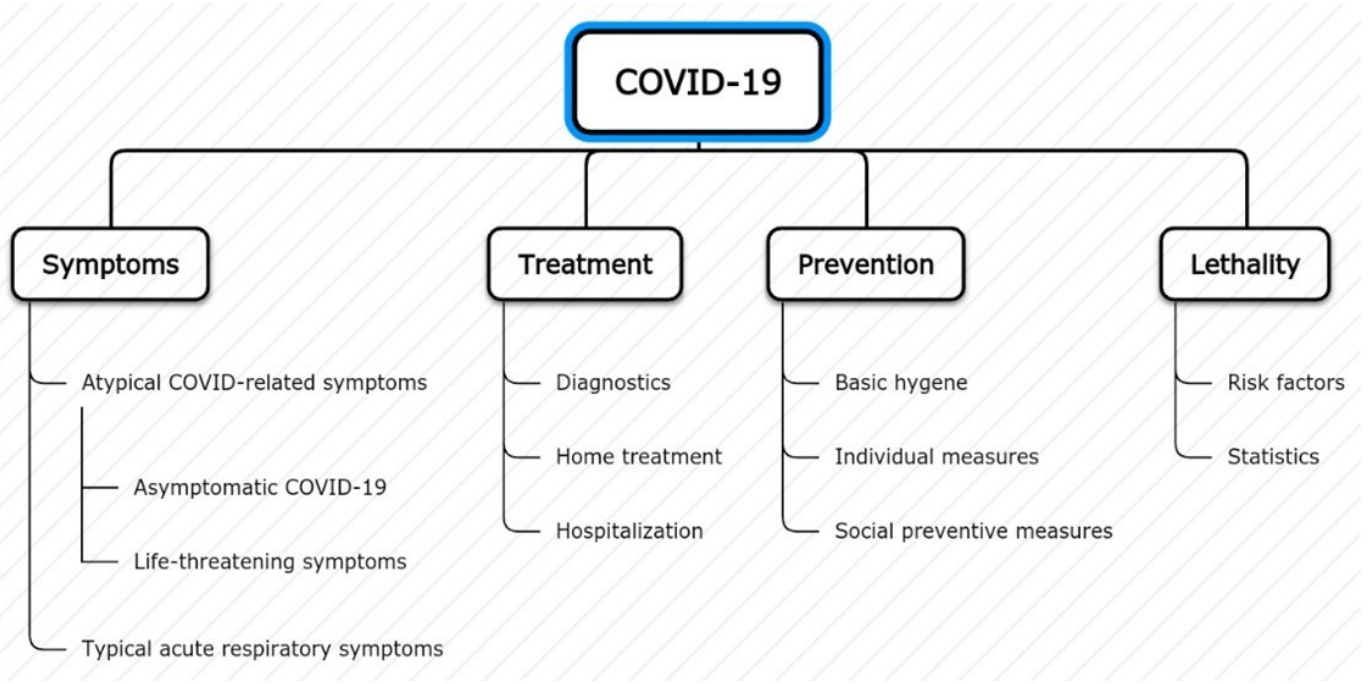
Figure 1 - COVID-19 thematic frame (mid-2020) DOI: